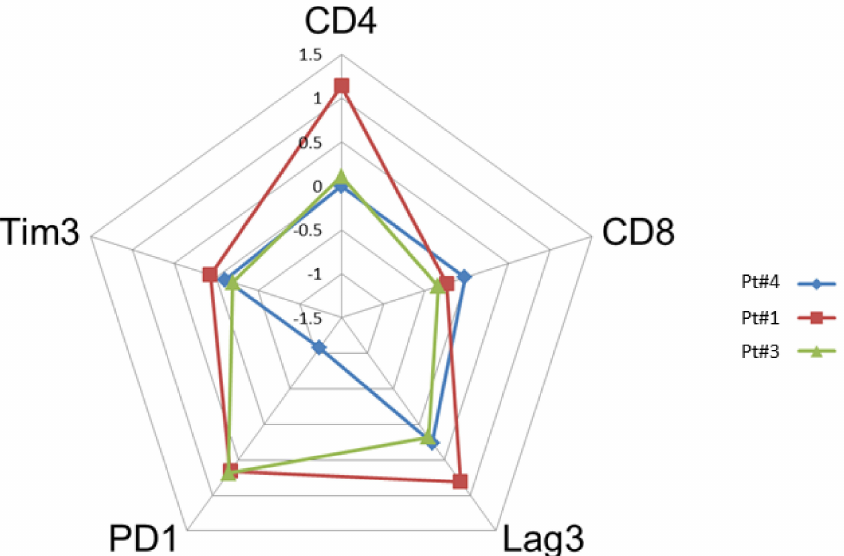
Figure 2. Comparison of the intensity of staining by immunohistochemistry of tumor biopsies before and after anti-PD-1 (paired biopsy analysis, part A study). The evaluation of the cell densities (number of cells per square mm) was performed by immunohistochemical staining image analysis for the CD4, CD8, Lag-3, Tim3 and PD-1 markers in patients #1, #3 and #4 before and after anti-PD-1 treatment. The diagram shows a summary of the fold changes for the main relevant markers. The numeric scale shown is 10 logs (logarithmic scale) and indicates the variations before and after anti-PD-1 for each marker studied. 0 indicates no change, 0.5 indicates a 2-fold increase in staining, and 1 indicates a 10-fold increase in the staining